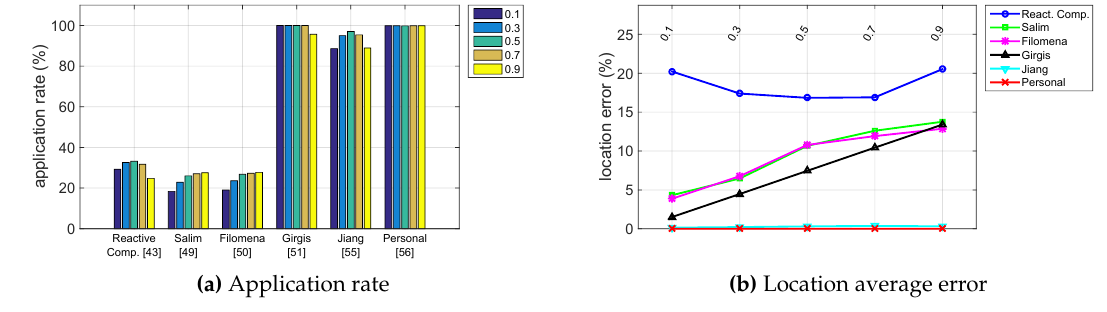
Figure 14. Normalized position analysis.